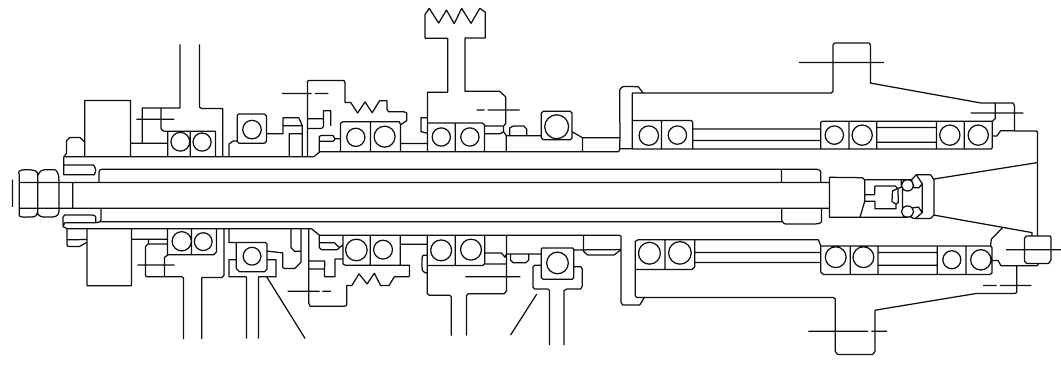
Figure 2: Schematic diagram of an OKADA VM500 spindle [13].